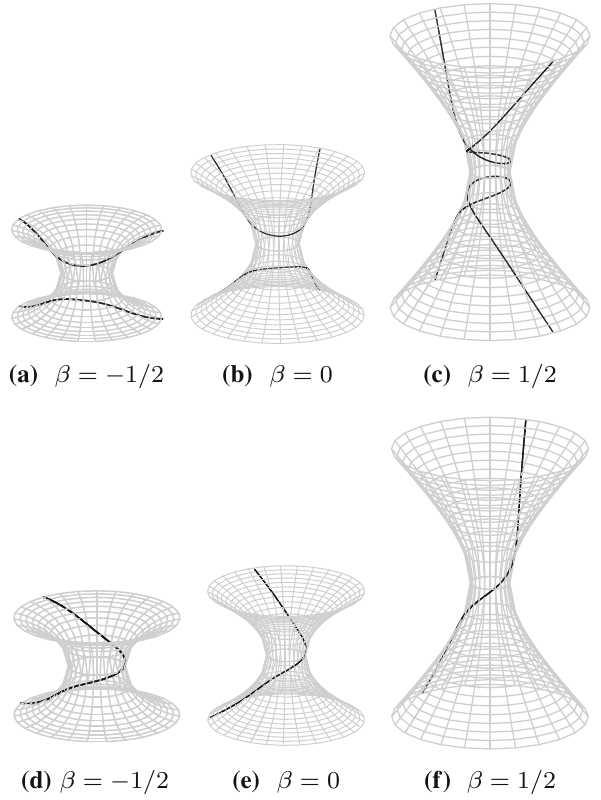
Fig. 5 Plots a – c show embedding diagrams for the case where non- radial geodesics are confined to one side of the wormhole, and r 0 = 1, β = − 1 / 2 , 0 , 1 / 2. In this case geodesics do not cross the throat since − r 0 L √ ≥ 0, and therefore there they satisfy the condition L 2 E 2 − 1 E 2 − 1 exist reversal points. In c we show geodesics which overlap with itself in one caustic point. Plots d – f show embedding diagrams for passing non-radial geodesics through the wormhole throat, which satisfy